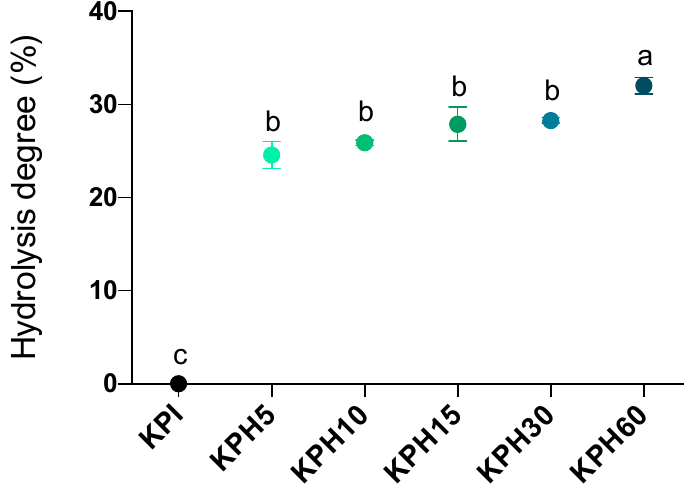
Figure 1. Hydrolysis degree time-course of the KPI during enzymatic hydrolysis by Bioprotease at 5 (KPH5), 10 (KPH10), 15 (KPH15), 30 (KPH30) and 60 (KPH60) min. Data are expressed as the percentage of cleaved peptide bonds (left y-axis). Values are represented as means ± standard deviation of three determinations. Statistical differences are marked with different letters ( p < 0.05).